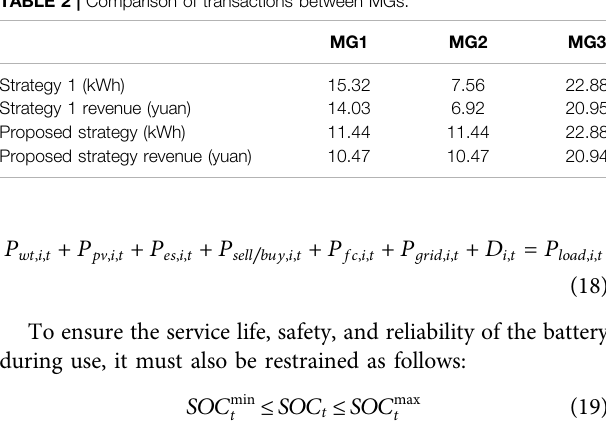
TABLE 2 | Comparison of transactions between